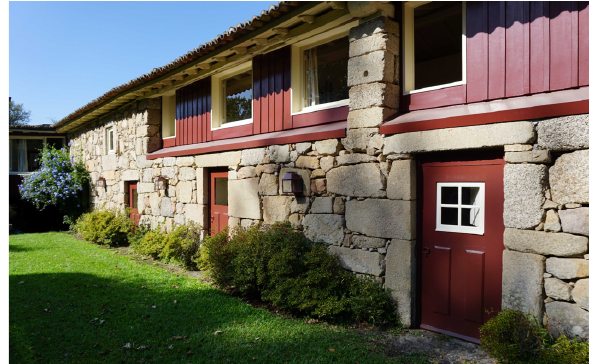
Figure 4. Façade facing the backyard.